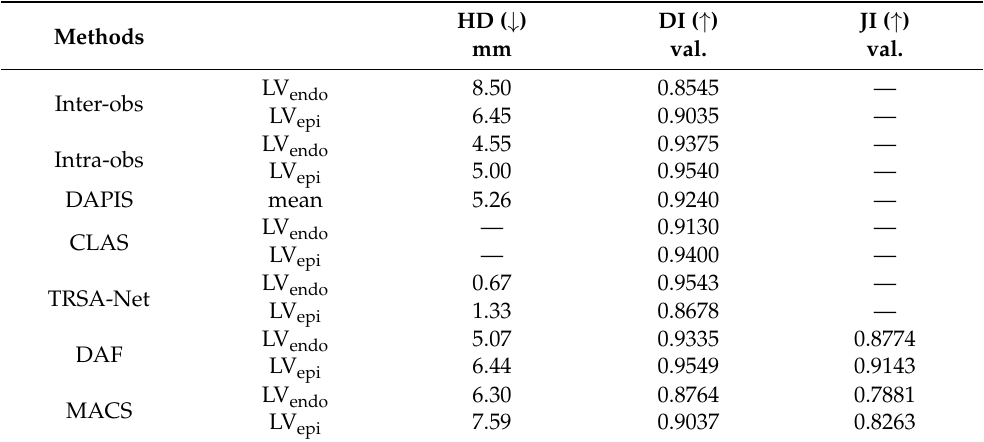
Table 5. Comparison with SOTA supervised methods on the CAMUS dataset. The up arrow indicates expecting a higher